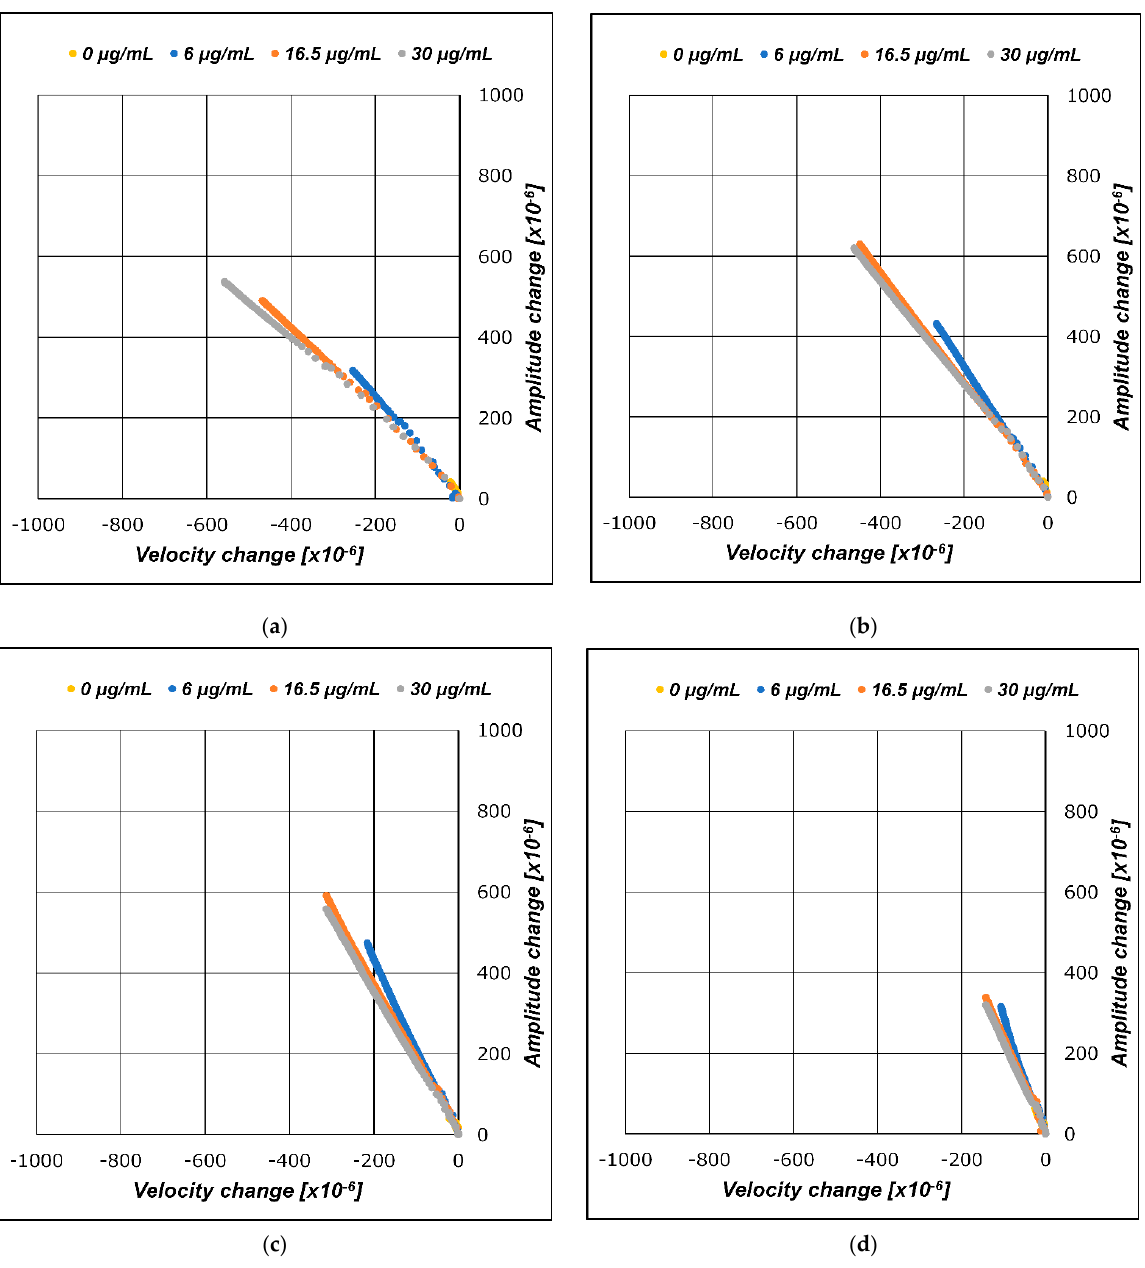
Figure 9. A/V plane plot for gold nanoparticle-conjugated secondary antibody-binding step. Secondary antibodies conjugated with gold nanoparticles of diameters of ( a ) 10 nm; ( b ) 15 nm; ( c ) 20 nm; ( d ) 30 nm.